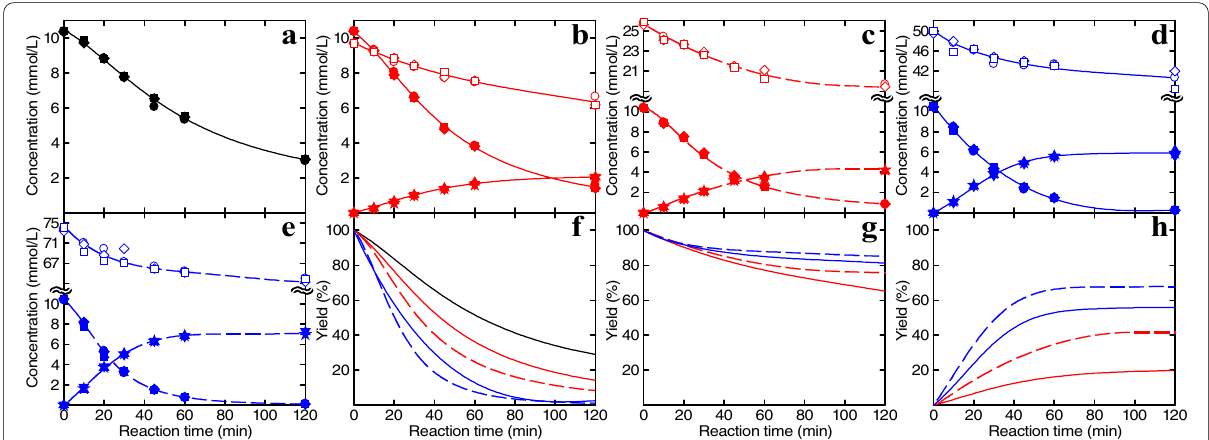
Fig. 6 Time courses of changes in the recovery yields of Va (filled circles, filled diamonds, and filled squares) and Cr (open circles, open diamonds, and open squares), and yield of VaCr (filled stars, filled triangles, and filled inverted triangles) in the systems [ a Cr0 (solid black lines), b Cr10 (solid red lines), c Cr25 (dotted red lines), d Cr50 (solid blue lines), and e Cr75 (dotted blue lines)], and in the recovery yields of Va ( f ) and Cr ( g ), and in the yield of VaCr ( h ). Filled circles, open circles, and filled stars show the 1st trial. Filled diamonds, open diamonds, and filled triangles show the 2nd trial. Filled squares, open squares, and filled inverted triangles show the 3rd